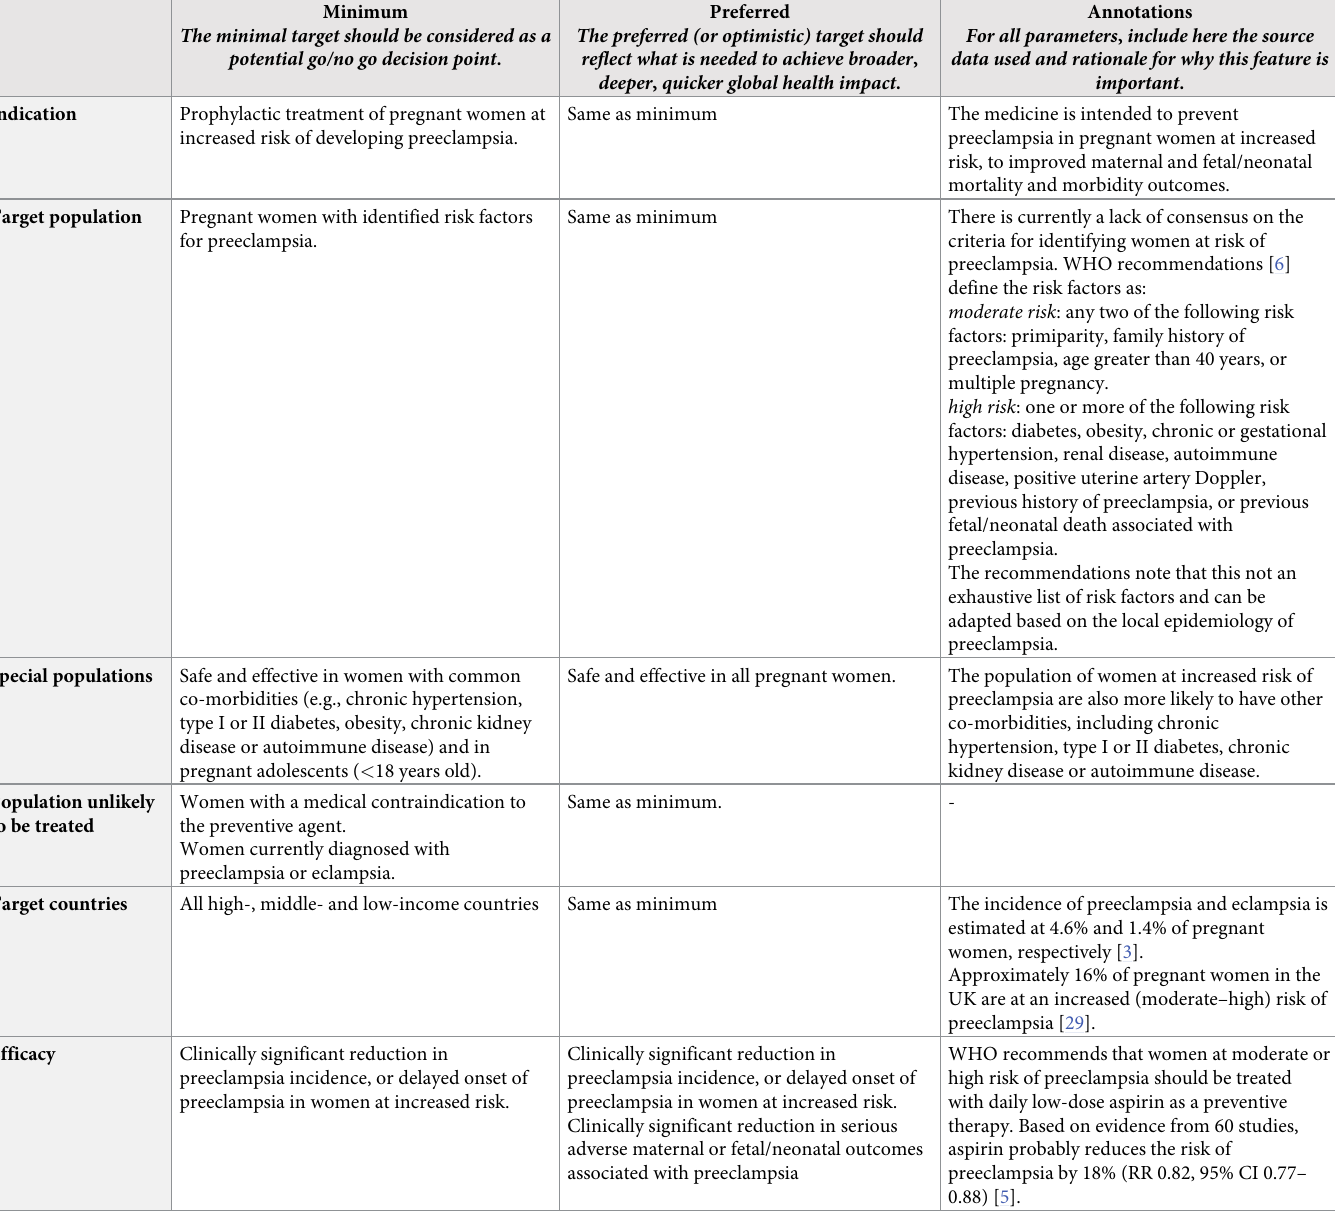
Table 1. Target product profile for medicines to prevent preeclampsia.